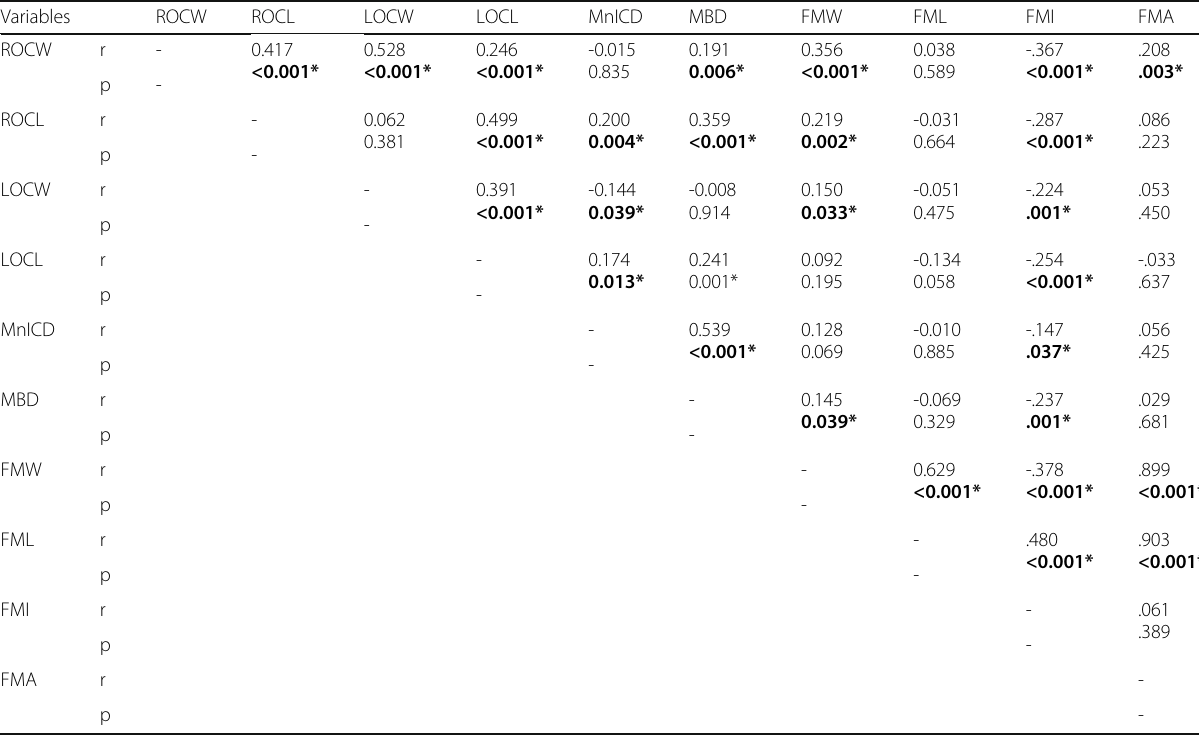
ROCW : Right occipital condylar width, ROCL : Right occipital condylar length, LOCW : Left occipital condylar width, LOCL : Left occipital condylar length, MnICD : Minimum intercondylar distance, MBD : Maximum intercondylar distance, FMW : Foramen magnum width, FML : Foramen magnum length, FMI : Foramen magnum index, FMA : Foramen magnum area, *significant p